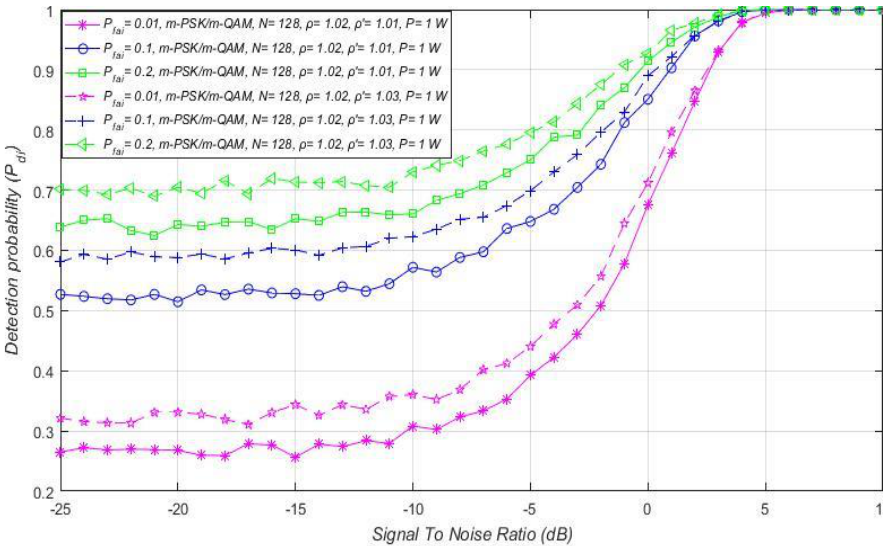
Figure 16. Detection probability vs SNR relationship for RA system with distinct false alarm probabilities and different combinations of NU and DT factors.